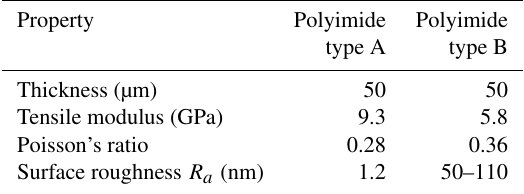
Table 1. Mechanical properties of polyimide type A (Upilex-S, UBE Industries) and type B (Kapton EN, DuPont) according to the data sheets and manufacturer information (status year